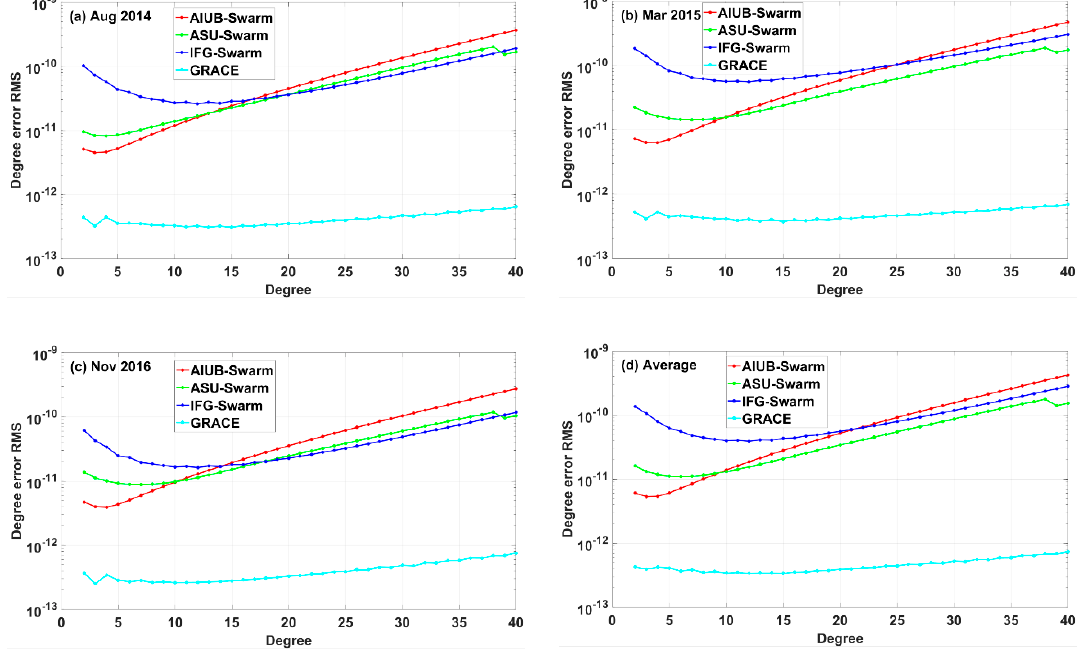
Figure 2. Internal coincidence accuracy of Gravity Recovery and Climate Experiment (GRACE) and Swarm models.